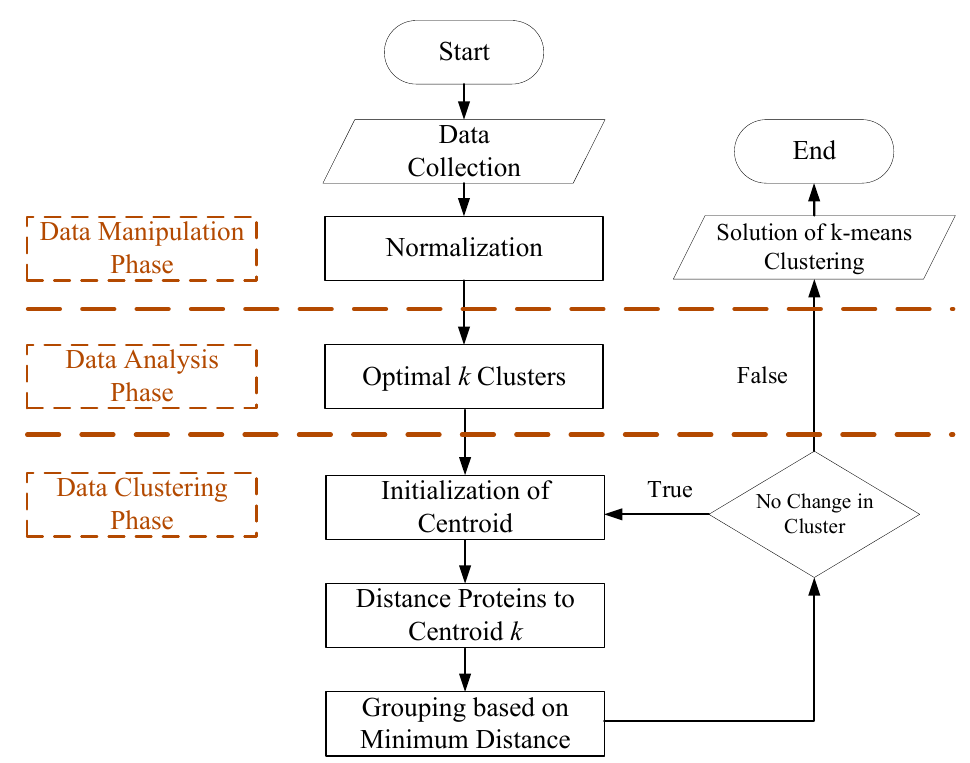
Figure 1. Flowchart of the k -means clustering algorithm.